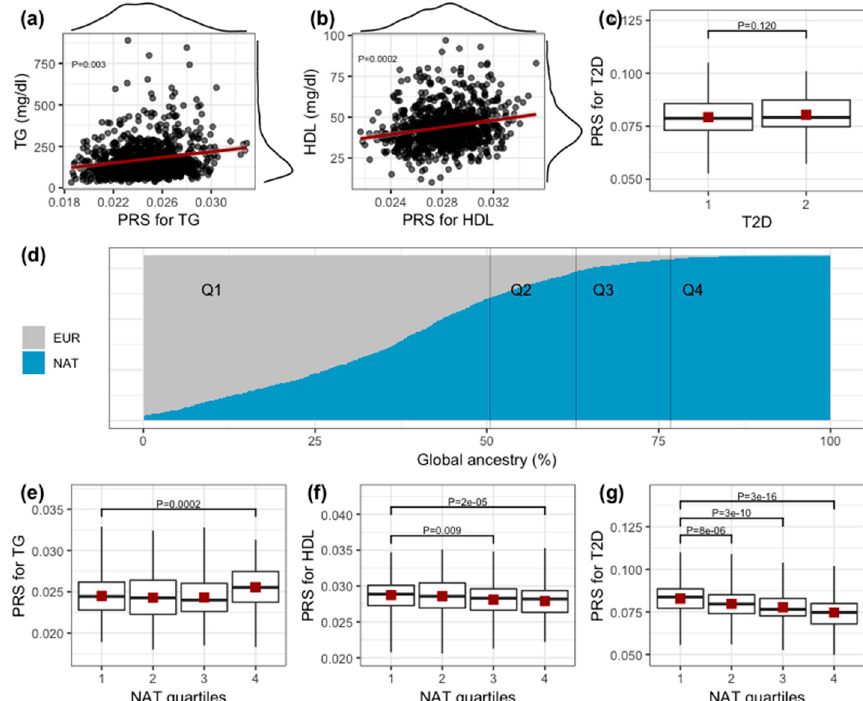
Figure 3. Relation between restricted-to-significant polygenic score (rsPS), its own trait level and ancestry. ( a–b ) show the relation between triglyceride (TG) and high-density lipoprotein (HDL) rsPS and its own lipid levels, as well as their density distribution. p value is adjusted for sex, age, BMI, type 2 diabetes (T2D) and ancestry. ( c ) shows the distribution of T2D rsPS between normoglycemic and diabetic individuals, p value is adjusted for sex, age, BMI and ancestry. ( d ) shows the individual global ancestry proportion of the studied sample. It was calculated from the two main parental populations of Mexicans, namely European and Native American ancestries. ( e – g ) show the distribution of TG, HDLc and T2D rsPS among the Native American quartiles of the studied sample. Unadjusted p values.